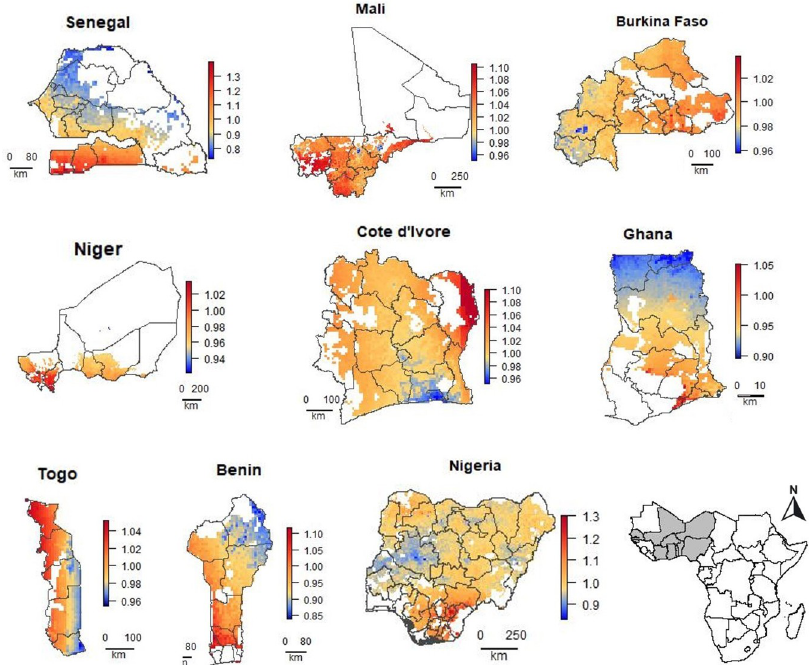
Fig 6. Predicted relative urea price (local price divided by the observed median national price) for areas with crop land in nine West African countries. For countries with two data sources (Africa Fertilizer and LSMS), the prediction of the best-performing model is shown.